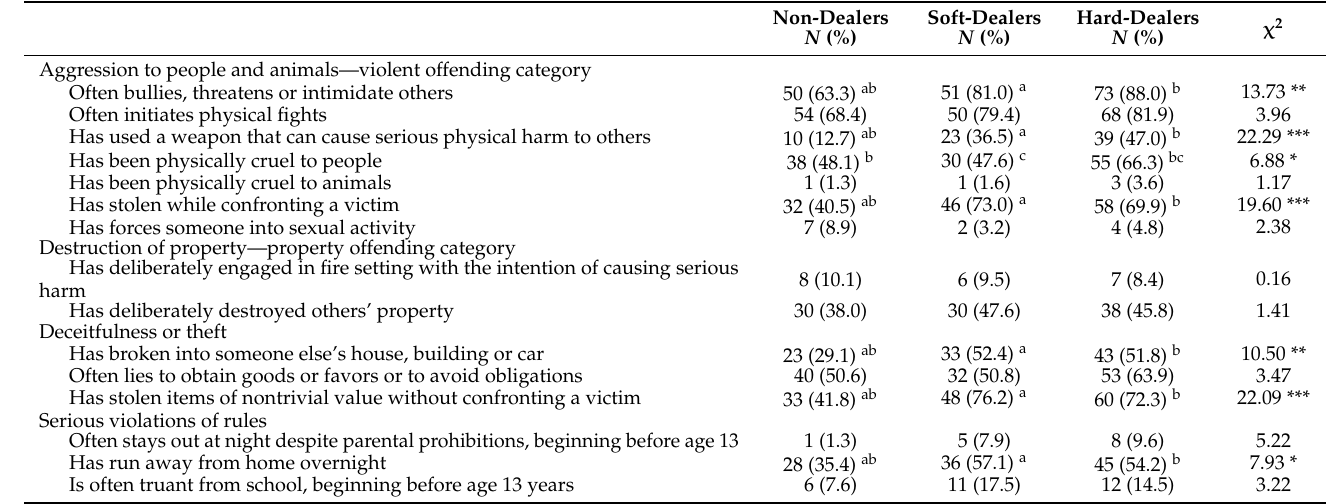
Table 5. Violent and Nonviolent Offenses Among Non-Dealers ( N = 79), Soft-Drug Dealers ( N = 63) and Hard-Drug Dealers ( N = 83).